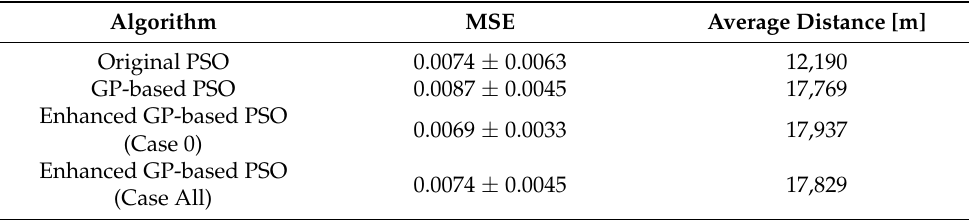
Figure 8. MSE using the original PSO, the GP-based PSO and the enhanced GP-based PSO. Table 6. Comparison between the three